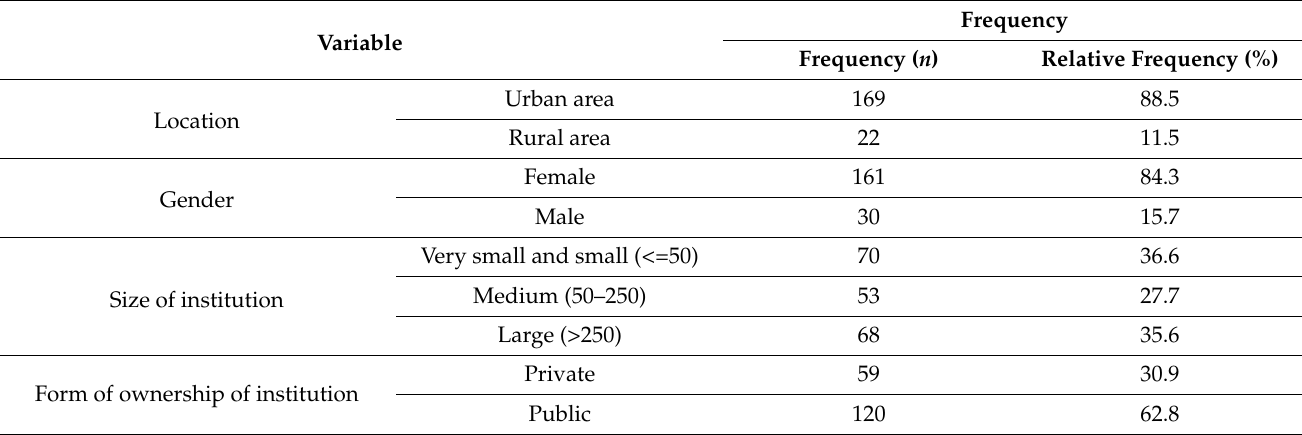
Table 3. The characteristics of the study population.